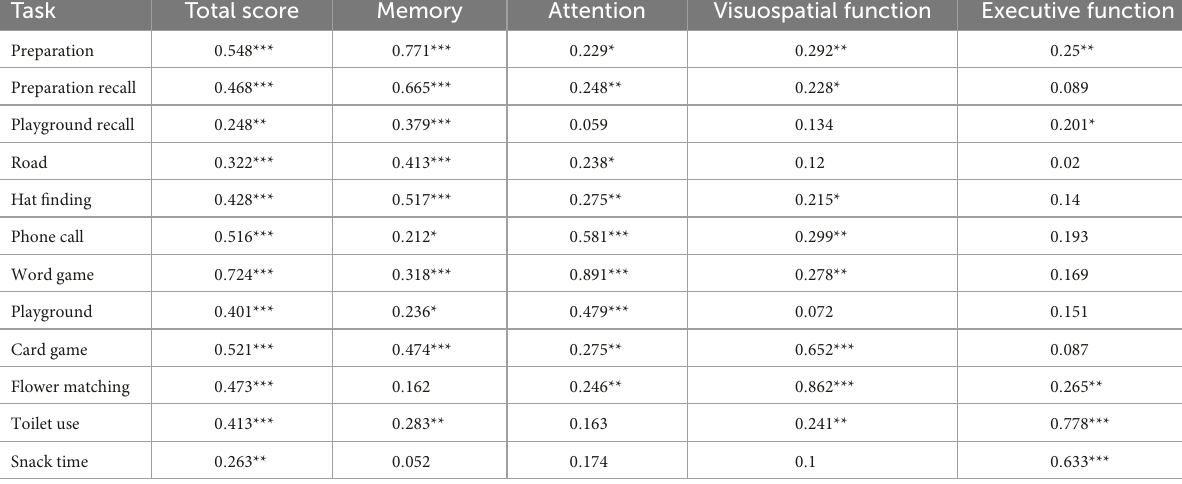
TABLE 5 Correlation coefficients of each task of VARABOM test with total score and cognitive subdomains. Task Total score Memory Attention Visuospatial function Executive function